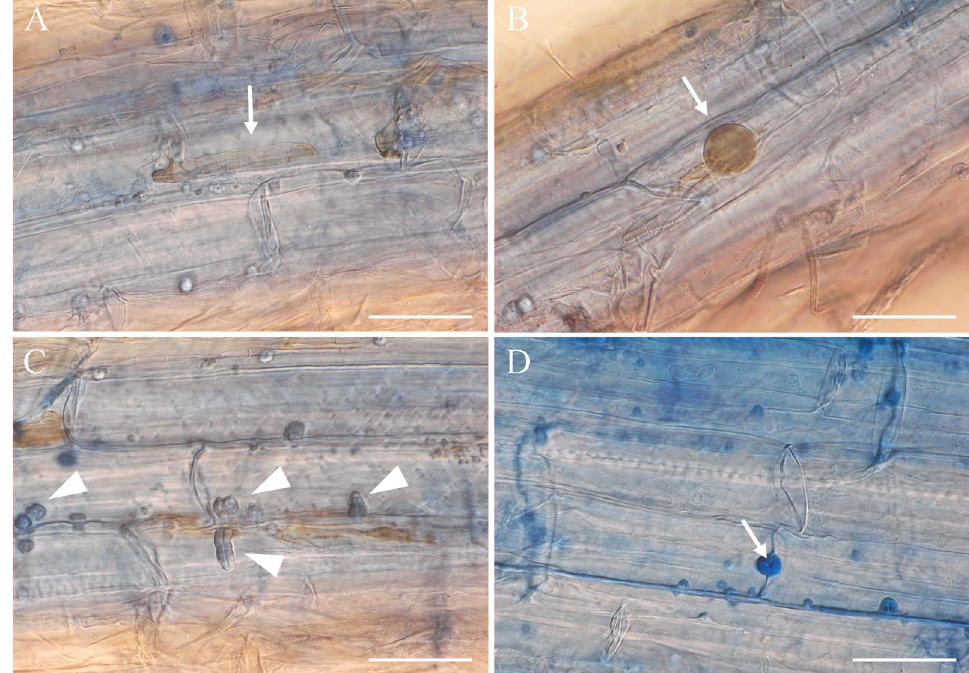
Fig. 5 Light micrographs of interaction between Polydomus karssenii and wheat roots. a , b Formation of microsclerotia (arrows) inside the plant cells. c Formation of callus tissues/papillae (arrowheads) assumingly as a plant response to fungal colonisation. d En face view of a callosic papilla‑like structure formed between two adjacent root cells; the sample was stained with cotton blue. Plants grown on MS medium. Bars